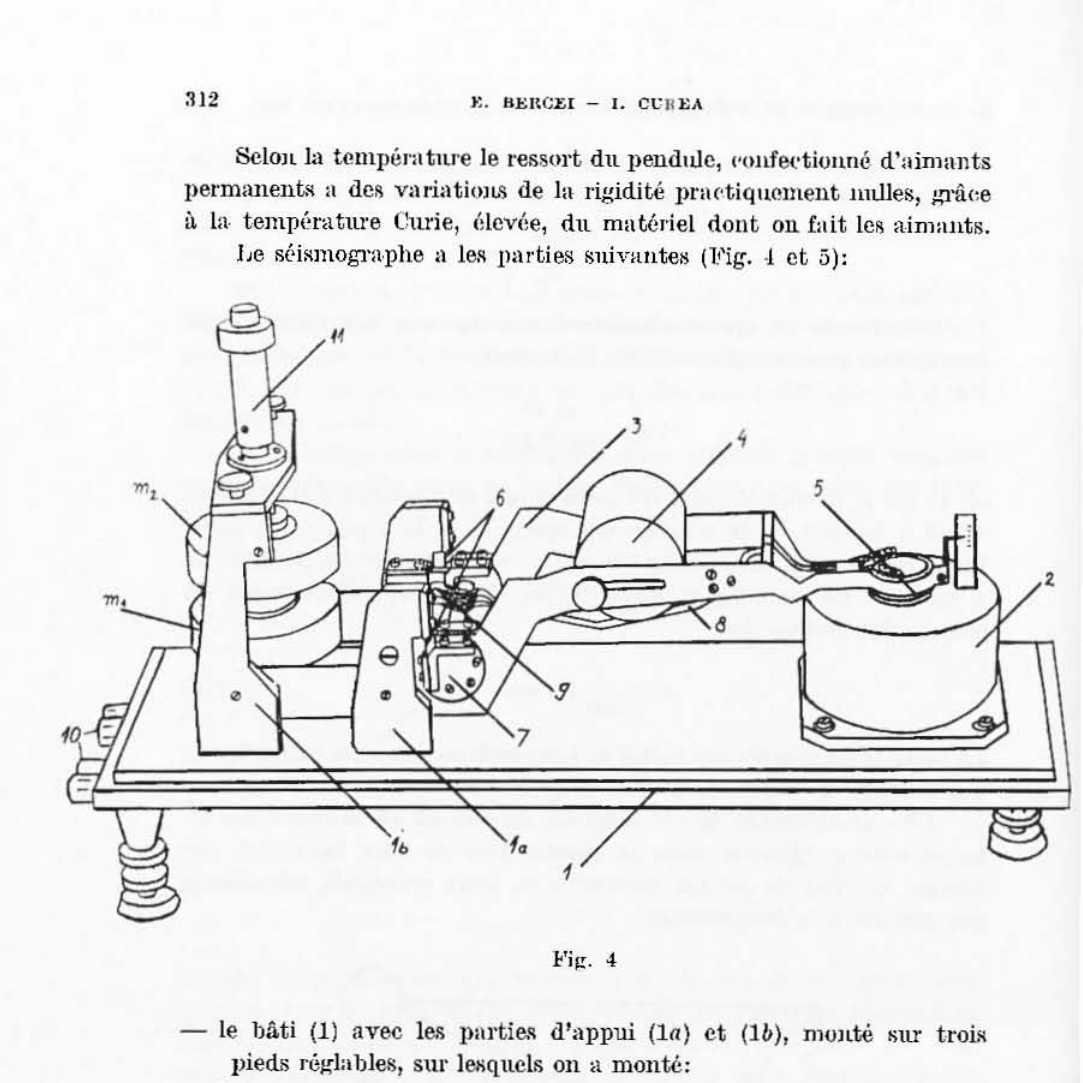
I.a sllSpellSioH de In pal'tie mobile est rcaliscc Plll· dc~ lam6/oi d'ader d'Ime grosseur de 0,1 mm (6), monWes eH croix. J/e (,hangemcnt des lamelles, 011 le fai t fllcilcmeut grace :In ruspositif xpécial monti! SUI' 1:1 pllrtie mobile (7). J.a t'QlllluClte éledrique qui p:lrt des delL'X hvhines paSrie pa·r 1m turan rigidement lié à l'équ.illemcnt mobile (8) et. est {·Olmectée